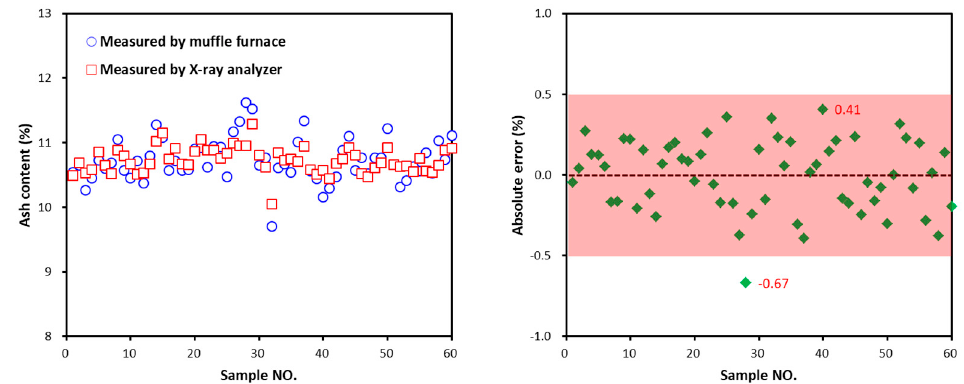
Figure 7. The difference ( left ) and absolute error ( right ) between the ash contents measured by muffle furnace and X-ray analyzer for industrial heavy medium clean coal with ash content between 9.20% and